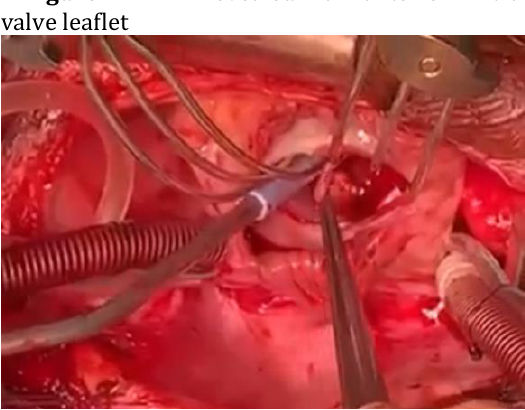
Figure 3: Intra-operative photo of rupture papillary muscle